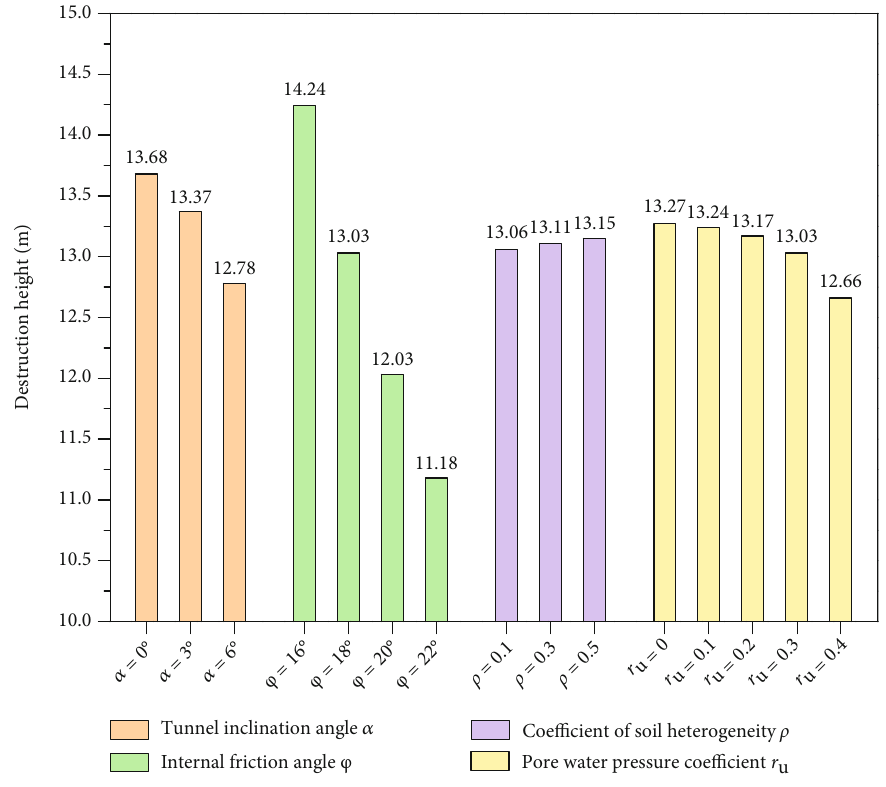
Figure 5: The in fl uence of parameters on the height of the failure